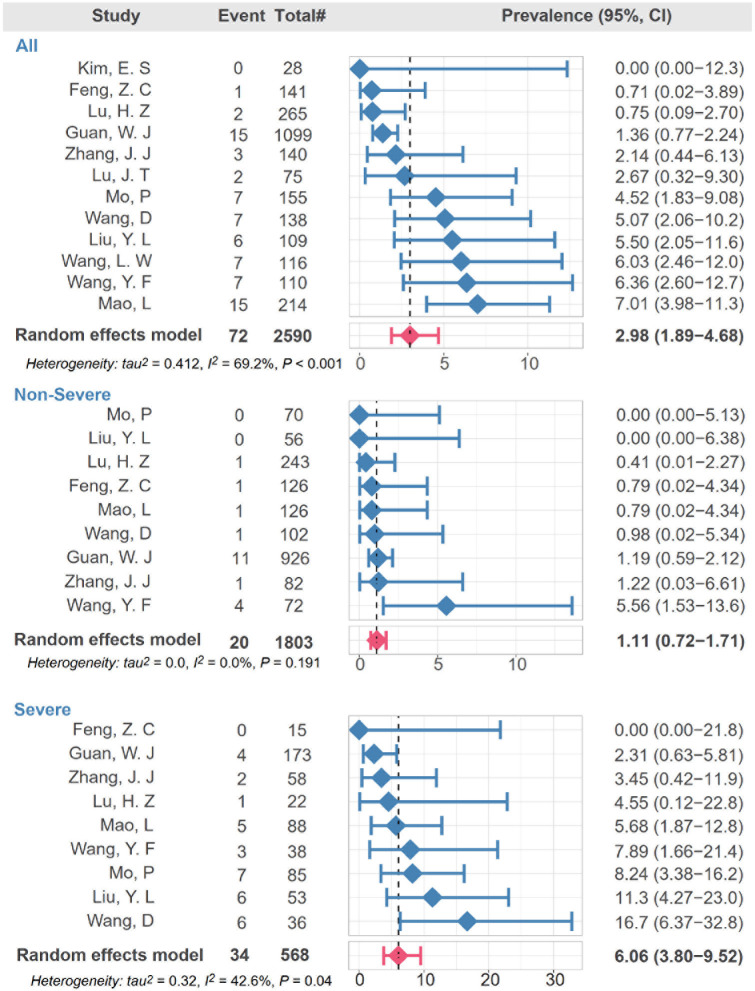
Meta-analysis revealing association of stroke with disease severity of COVID-19. Random intercept logistic regression model was used to estimate pooled prevalence and I2 was used to show heterogeneity among studies. The red bar denotes the pooled prevalence using random effect model.